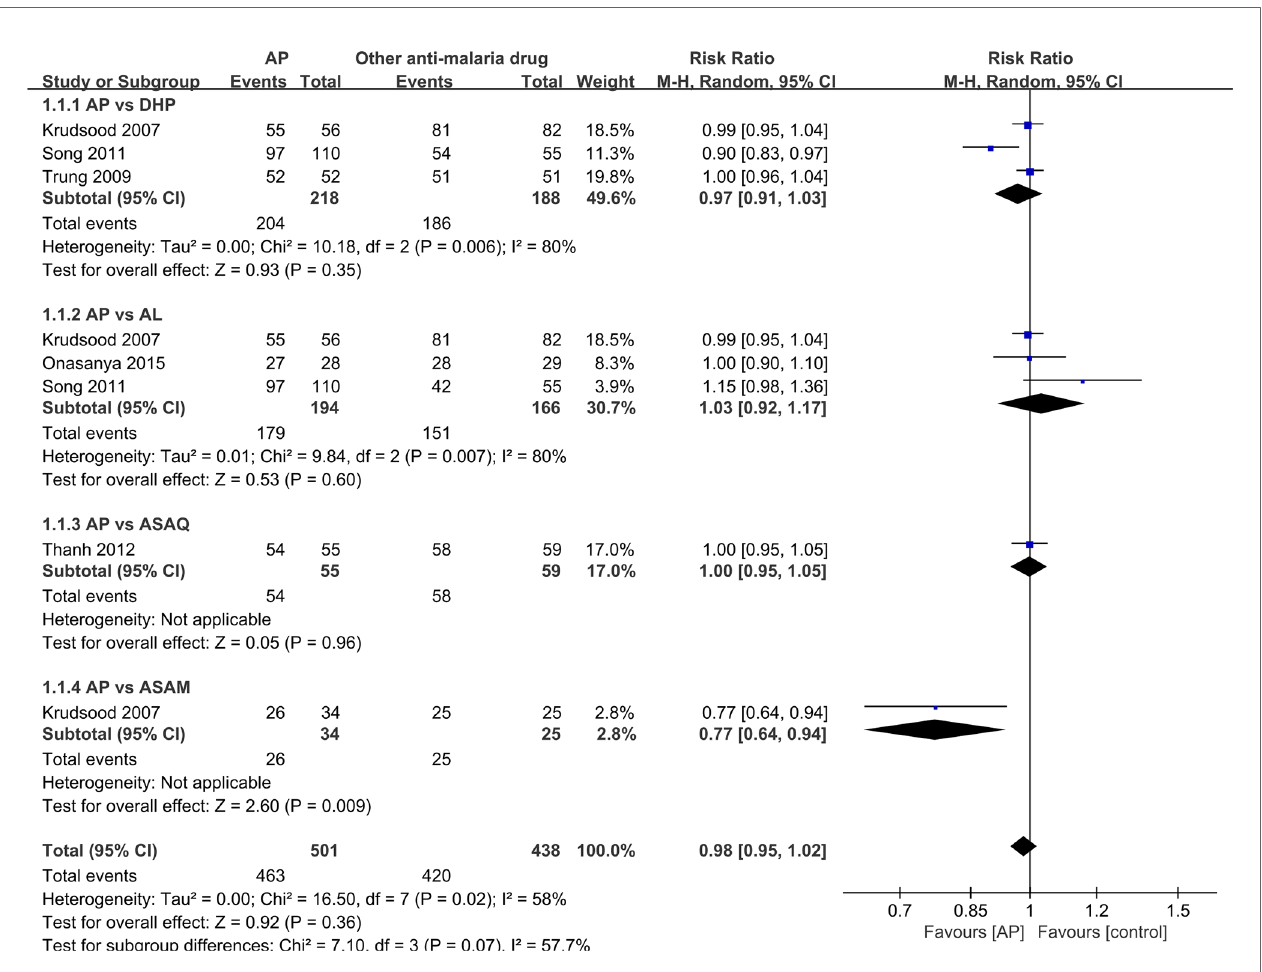
FIGURE 2 | Comparative drug ef fi cacy between artemisinin – piperaquine and competing interventions.